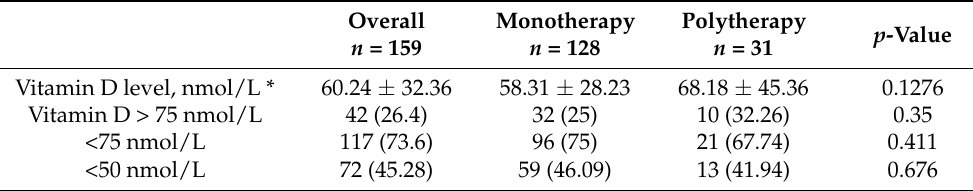
Table 2. Vitamin D level according to antiseizure medication type.